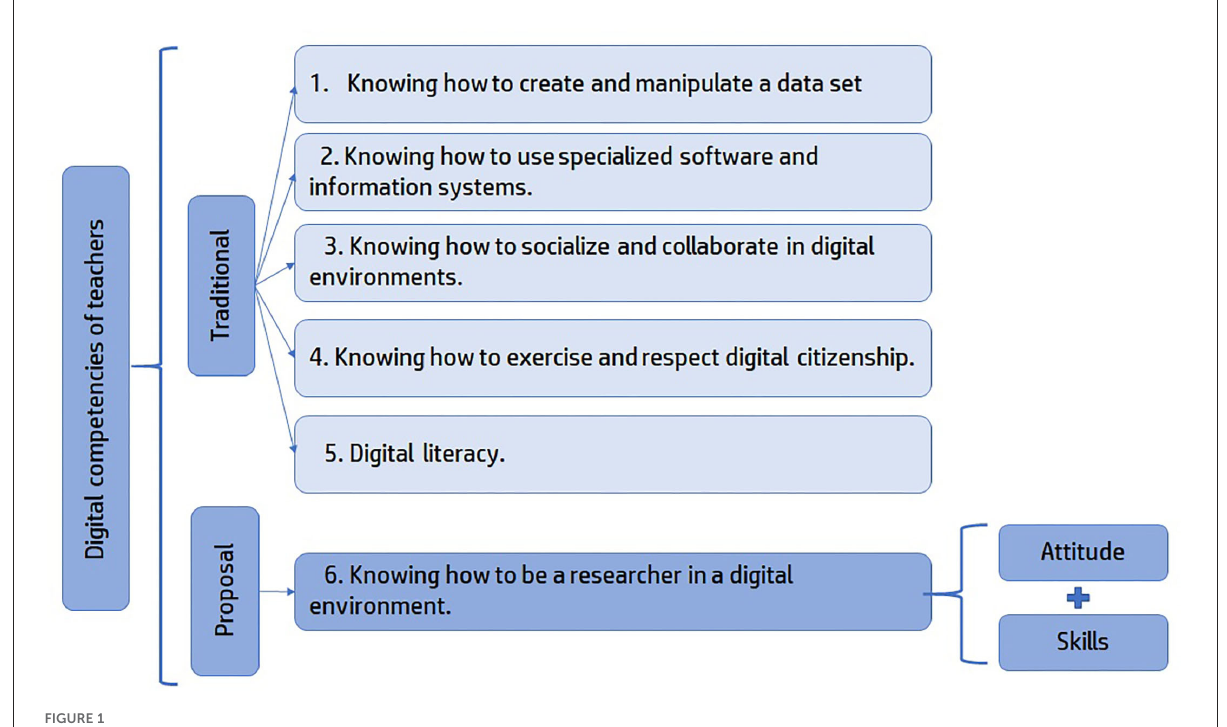
FIGURE1 Traditional and proposed digital competencies of